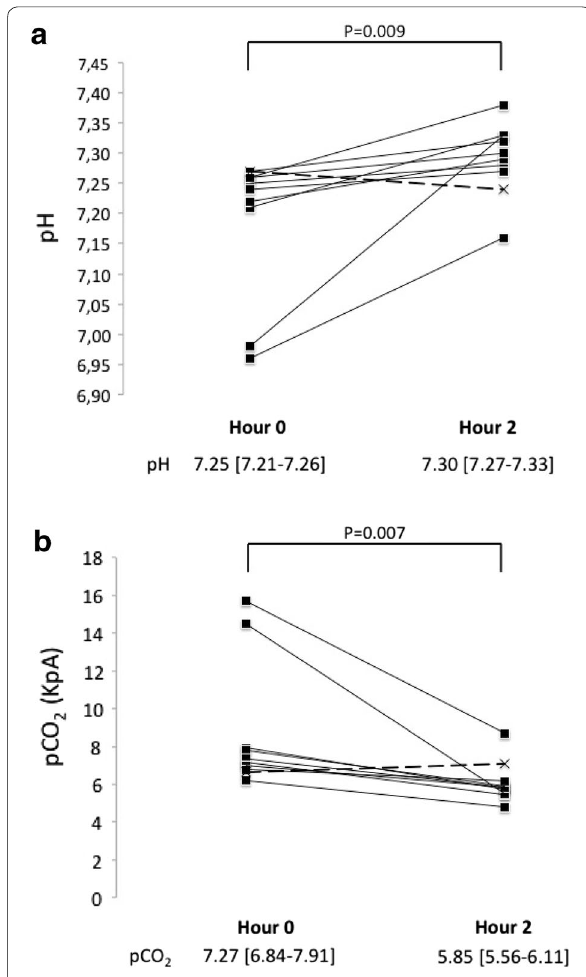
Fig. 4 Change of pH ( a ) and pCO 2 ( b ) at admission and at hour 2 in ten children with severe acidosis treated with nasal high flow for status asthmaticus, including one child ( discontinuous line ) who failed to